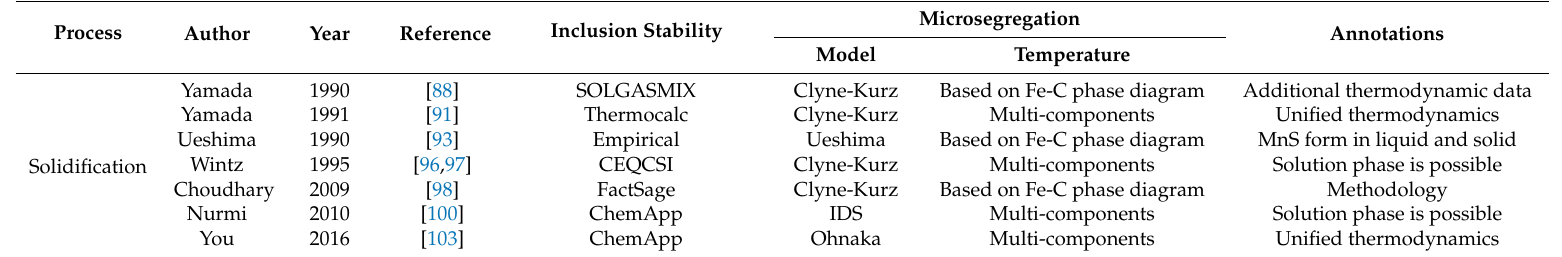
Table 2. List of thermodynamic models on inclusion formation during solidification.